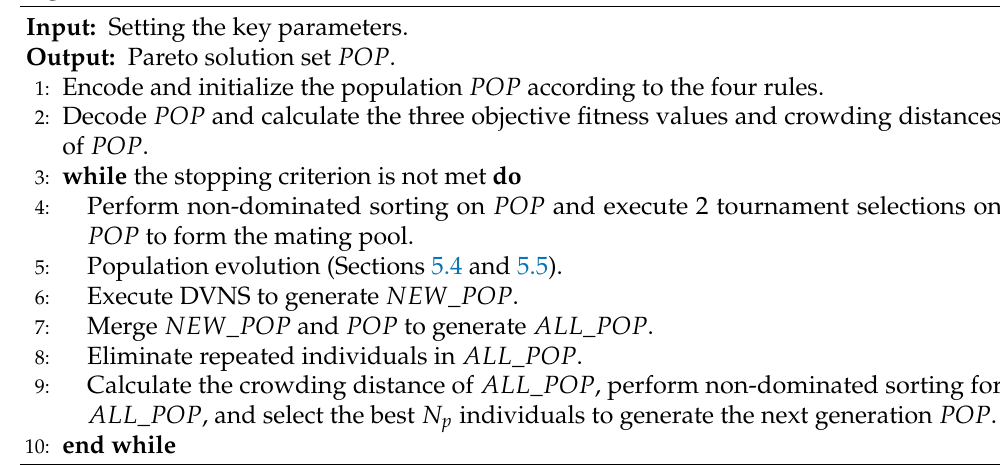
Algorithm 1 The framework of the